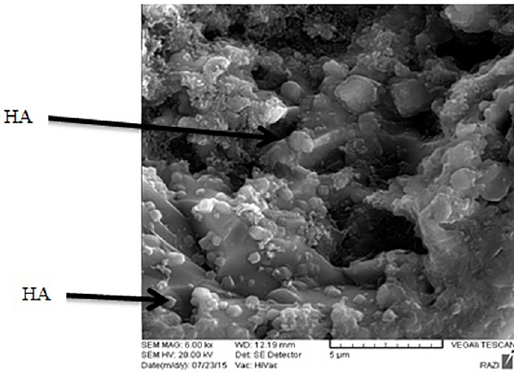
Figure 7. SEM image of pressed sample under pressure of 500 MPa